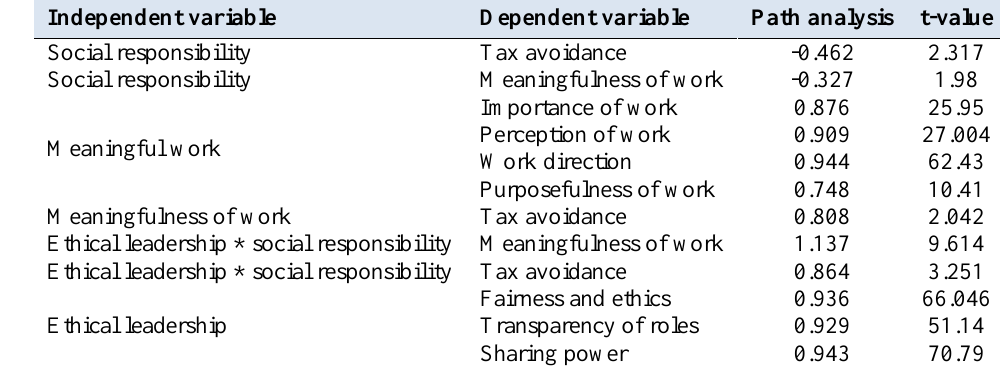
Table 4. Estimated results of the research model